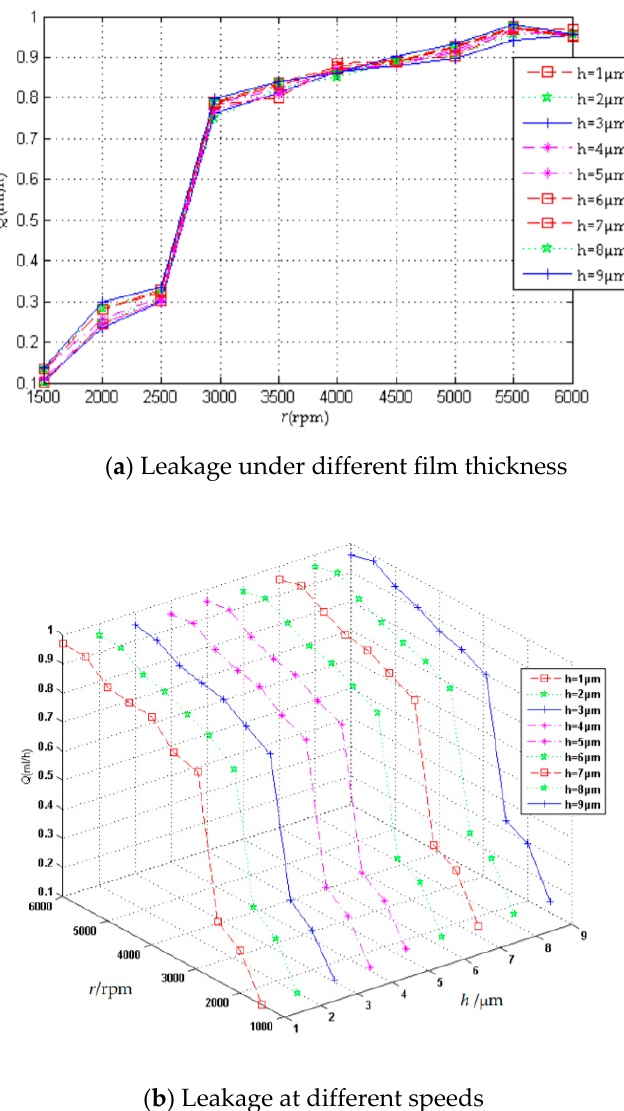
Figure 17. Leakage under different rotating speeds and fluid film thickness.